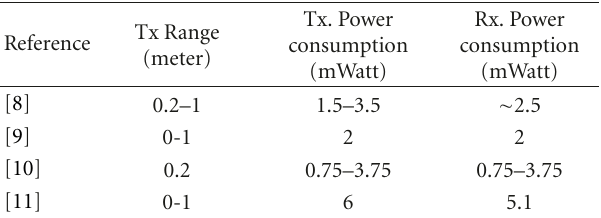
Table 1: Low power and short range RF